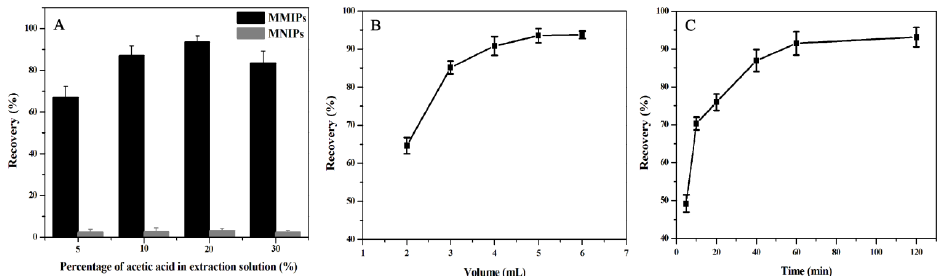
Figure 9. Optimization of conditions affecting the extraction effect of MTX on the MMIPs, including ( A ) percentage of acetic acid, ( B ) eluent volume, and ( C ) elution ( A ) percentage of acetic acid, ( B ) eluent volume, and ( C ) elution time.